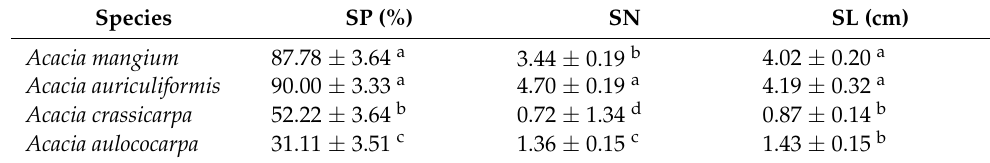
Note: SP = shooting percentage, SN = shoot number, SL = shoot length. Values are expressed in mean ± standard error. Significant differences among species are indicated by different lower-case letters ( p ≤ 0.05). Similar letters are not significantly different at p ≤ 0.05 based on Duncan Multiple Range